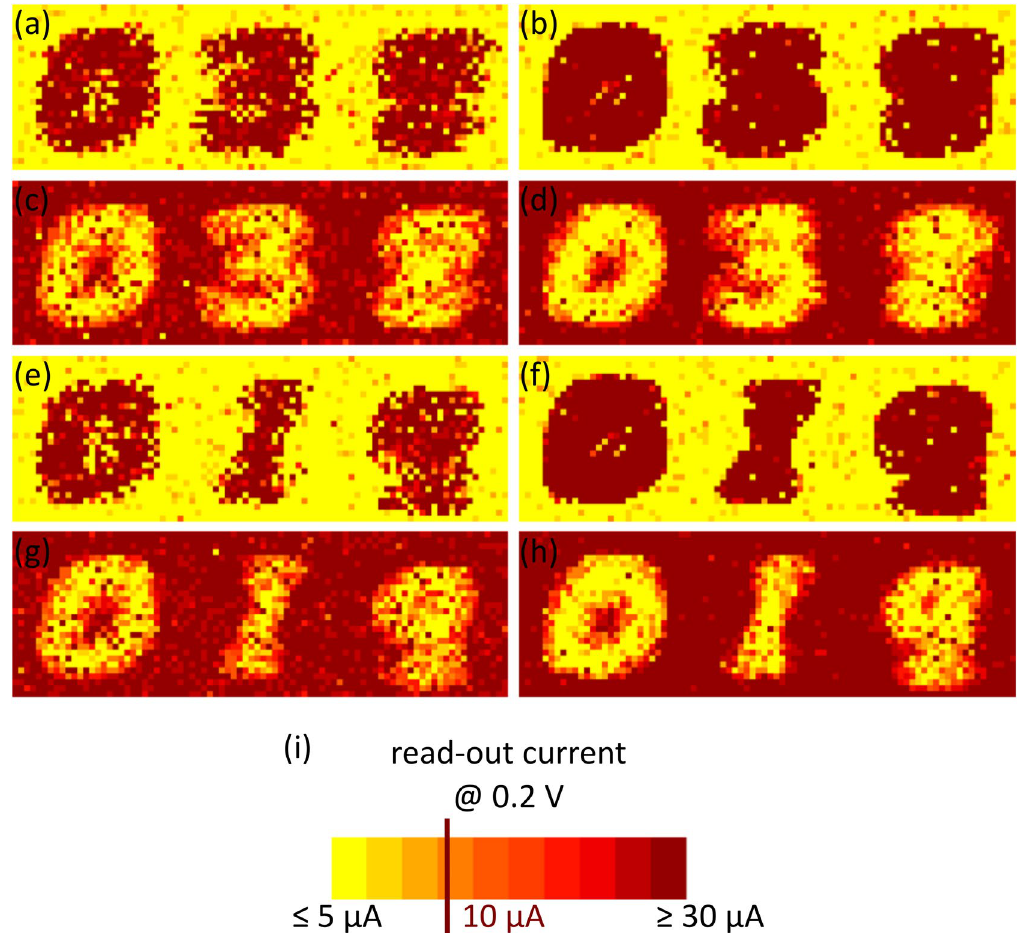
Figure 5. Receptive fields of learned patterns in hardware. The read-out currents of the RRAM devices measured with a voltage pulse V read with an amplitude of 0.2 V are depicted as two dimensional images. The pixel colour encodes the current of the respective RRAM device. In ( a – d ) the learned patterns are {0, 3, 8} using the set transition of the polycrystalline devices ( a ), the set transition of the amorphous devices ( b ), the reset transition of the polycrystalline devices ( c ) as well as the reset transition of the amorphous devices ( d ). In ( e – h ) the learned patterns are {0, 1, 9} using the set transition of the polycrystalline devices ( e ), the set transition of the amorphous devices ( f ), the reset transition of the polycrystalline devices ( g ) as well as the reset transition of the amorphous devices ( h ). In ( i ) the encoding of the read-out currents is